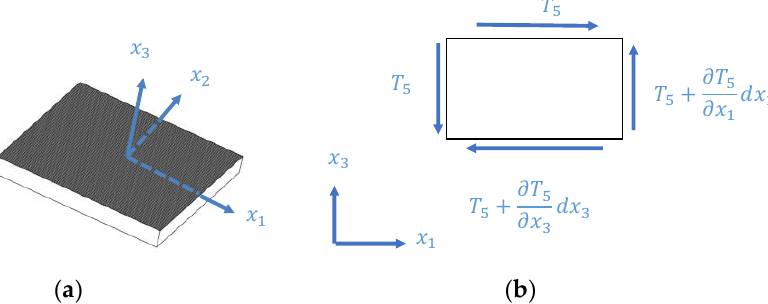
Figure 1. ( a ) Schematic of a shear-mode plate piezoelectric transducer polarized in the x 1 -direction; ( b ) infinitesimal shear element.